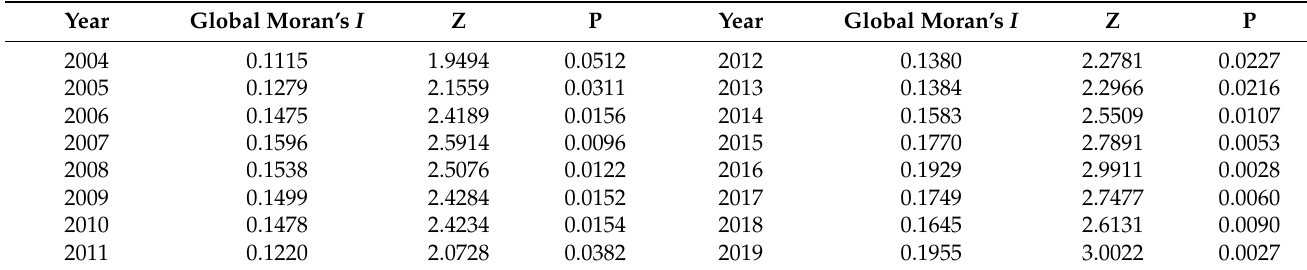
Table 2. Global Moran’s I of the co-agglomeration index of 30